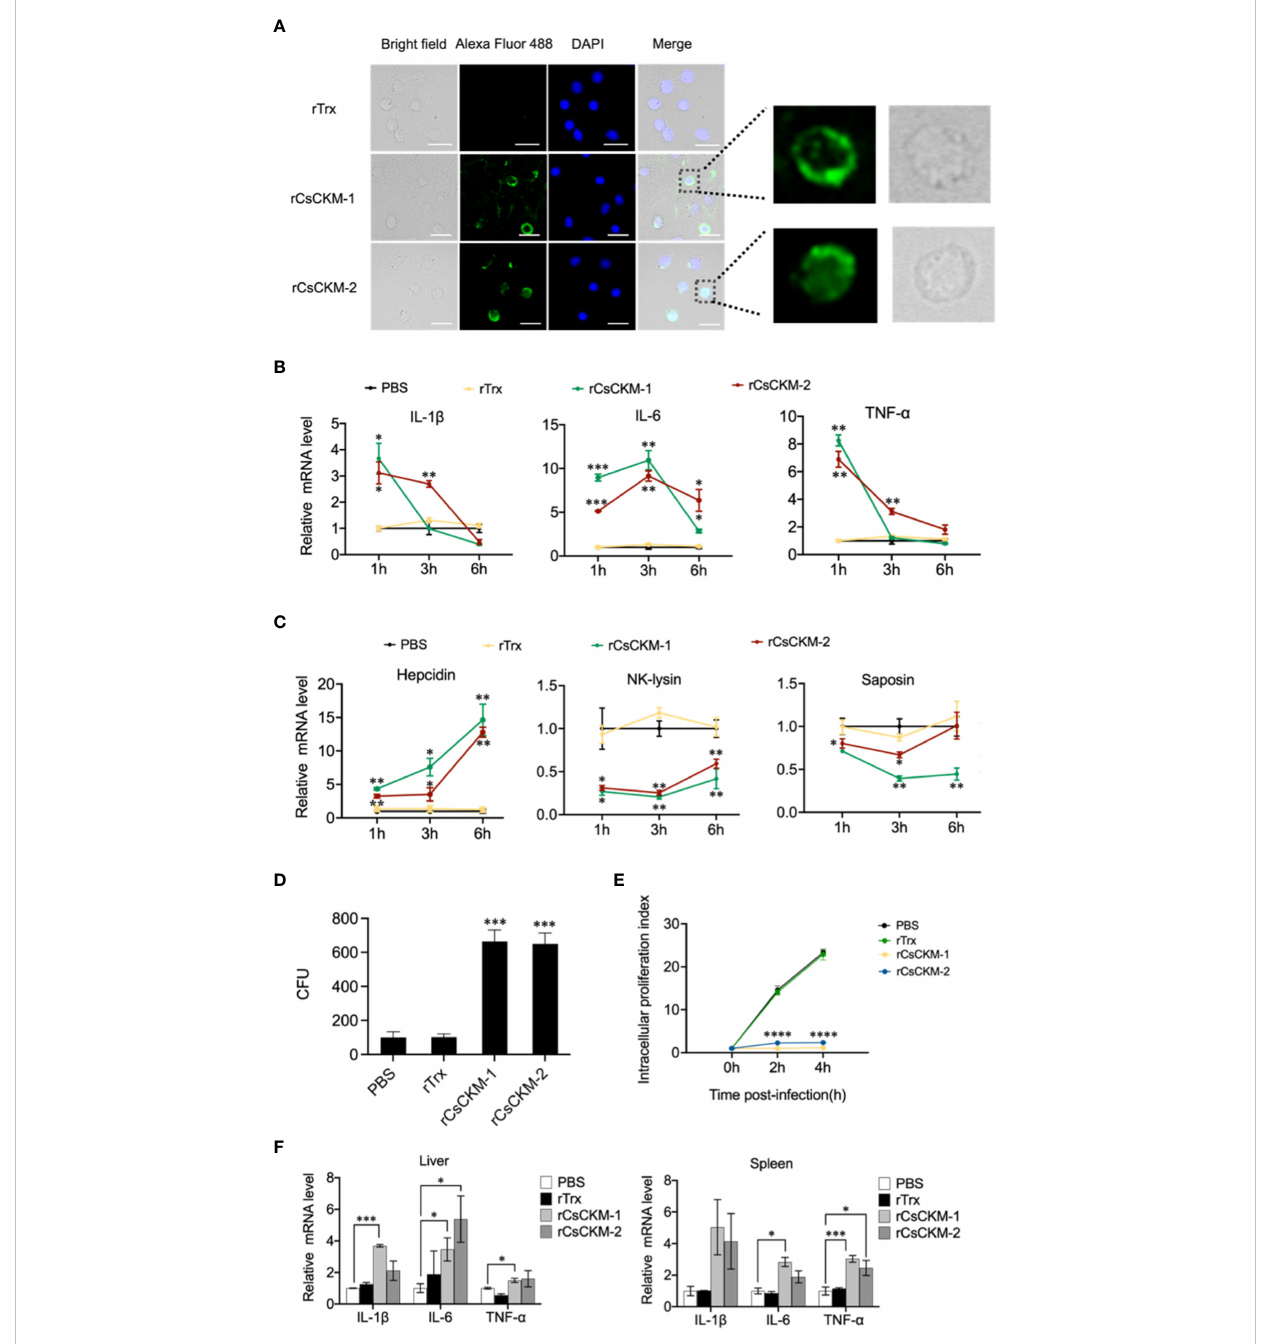
FIGURE 4 The effect of CsCKM-1/2 on IL-1 b , IL-6 and TNF- a expression and Edwardsiella tarda infection. (A) His-tagged rCsCKM-1/2 or rTrx was incubated with tongue sole PBLs for 1 h. The cells were stained with DAPI and treated with anti-His tag antibody and Alexa Fluor 488-labeled secondary antibody. The distribution of rCsCKM-1/2 in one cell was shown in the enlarged images. Scale bar, 10 m m. (B) The expression of IL-1 b , IL-6 and TNF- a in PBLs treated with rCsCKM-1/2, rTrx, or PBS (control) was determined at different times by qRT-PCR. (C) The expression of hepcidin, NK-lysin and saposin in PBLs treated with rCsCKM-1/2, rTrx, or PBS (control) was determined as above. (D) PBLs were pretreated with rCsCKM-1/2, rTrx, or PBS (control) for 2 h, and then incubated with E . tarda for 2 h. The number of phagocytosed bacteria was determined. (E) PBLs were pretreated with rCsCKM-1/2, rTrx, or PBS (control) and then infected with E. tarda . Intracellular bacteria replication at different hours was determined. (F) Tongue sole were infected with rCsCKM-1/2, rTrx, or PBS (control), and the expression of IL-1 b , IL-6 and TNF- a in spleen and liver was determined by qRT- PCR. For (B – D) , values are the means of triplicate assays and shown as means ± SD. * P < 0.05; ** P < 0.01; *** P < 0.001, **** P <